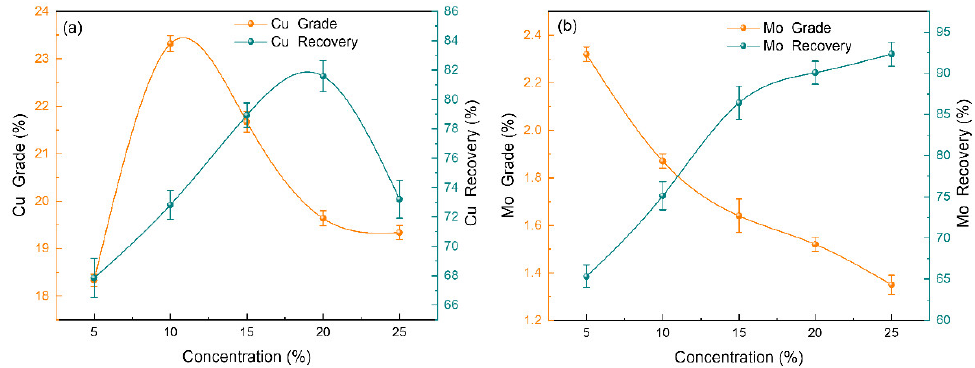
Figure 6. Effect of pulp concentration on the separation performance of a superconducting separator at a magnetic induction of 7 T and a feed velocity of 4 L/min. ( a ) Cu recovery from magnetic products; ( b ) Mo recovery from non-magnetic products.